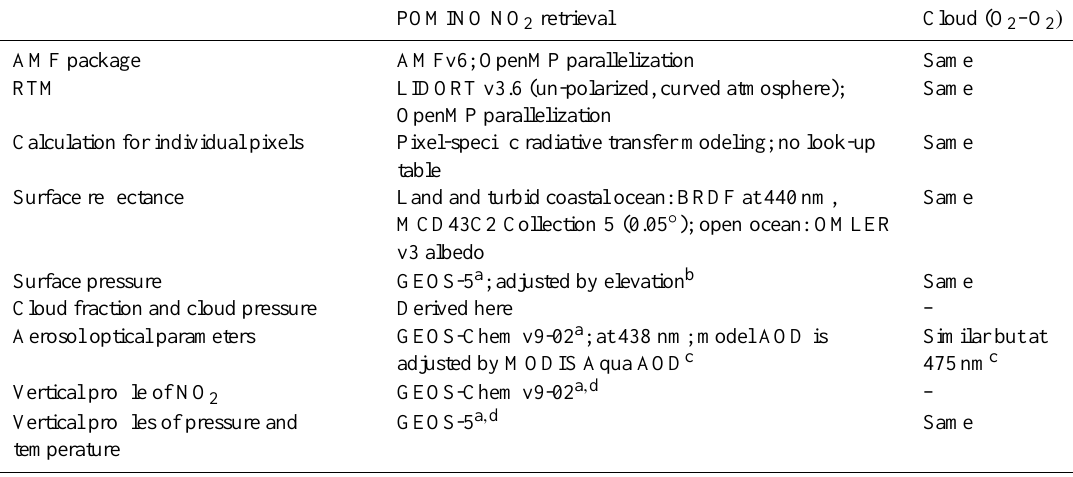
Table 1. Key tools and parameters used in POMINO and associated cloud retrievals.